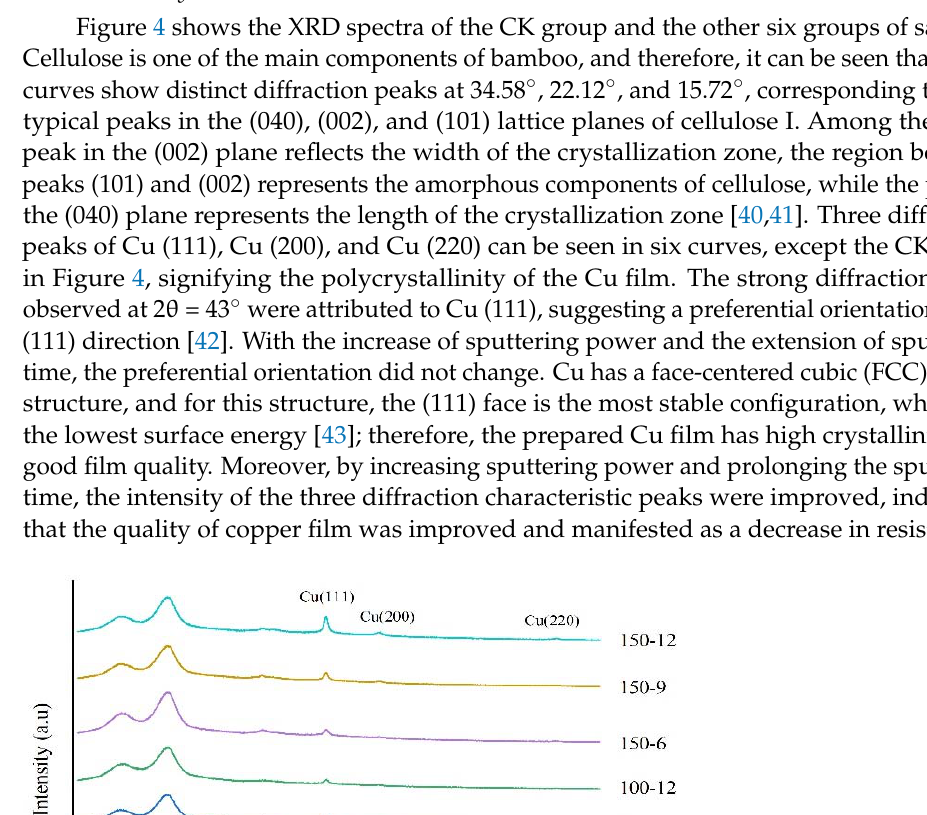
Figure 3. ( a ) The tensile mechanical properties of the bamboo fiber bundle and samples after mag- netron sputtering. ( b ) Comparison of tensile strength between conductive bamboo fiber bundle and other fiber materials.